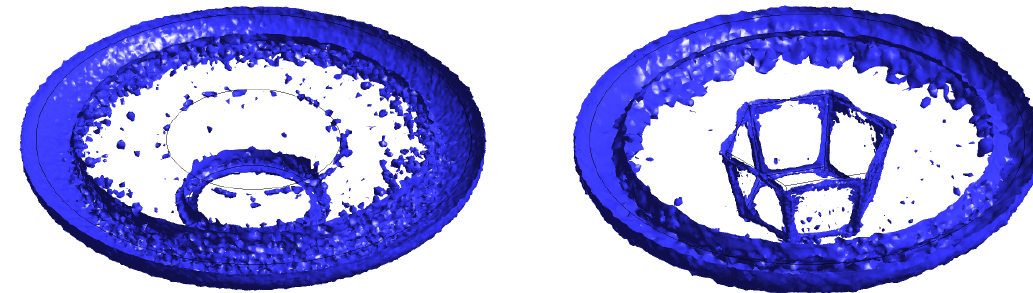
Figure 14. Isosurface of flow stress equal to 200 MPa for both FSW − C ( left ) and FSW − H ( right ) samples.